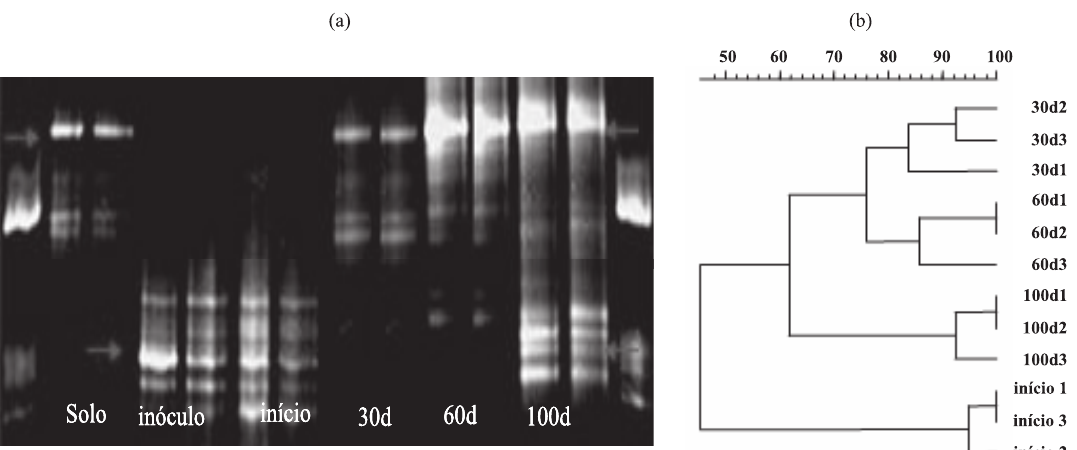
figura 5. (a) Fingerprint da comunidade de bactérias presentes no reator durante a biorremediação e (b) dendrograma de similaridades. d: dias; 1, 2 e 3: